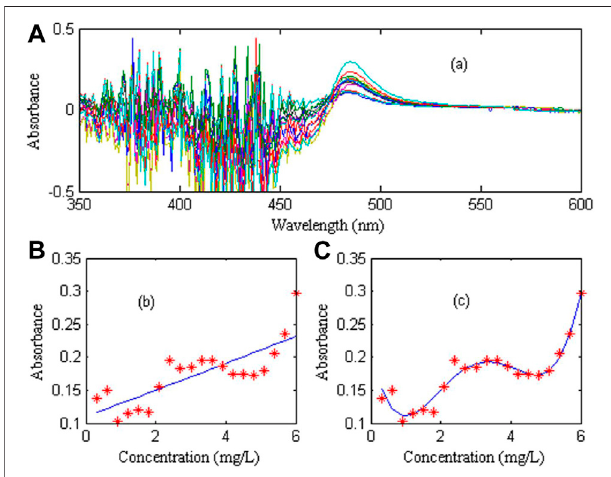
FIGURE 4 | Calibration curve for nickel. (A) Absorption spectra of nickel standard solutions with different concentrations: Show results in wavelength range from 475 nm to 600 nm and Absorbance range from 0 to 6 (never below 0). (B) Linear calibration curve. (C) Nonlinear calibration curve.